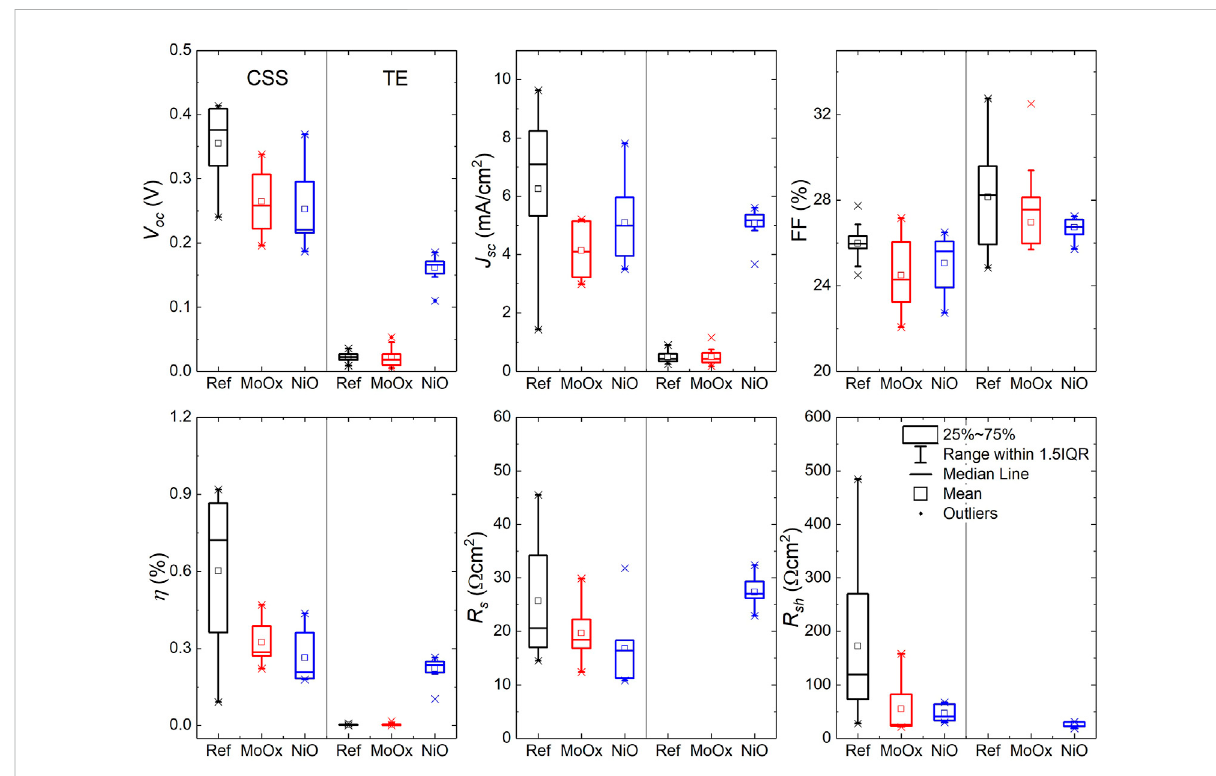
FIGURE 13 J-V parametersofsubstrateTEandCSSSb □ istheaveragevalueand×istheminimumand 2 Se 3 deviceswithincorporatedMoO x andNiOHTLs. maximum position. The three horizontal lines of each box stand for the 25%, 50% and 75% of the reading distribution. The whisker range is determined by the standard deviation of the sampled devices. IQR is the inter-quartile